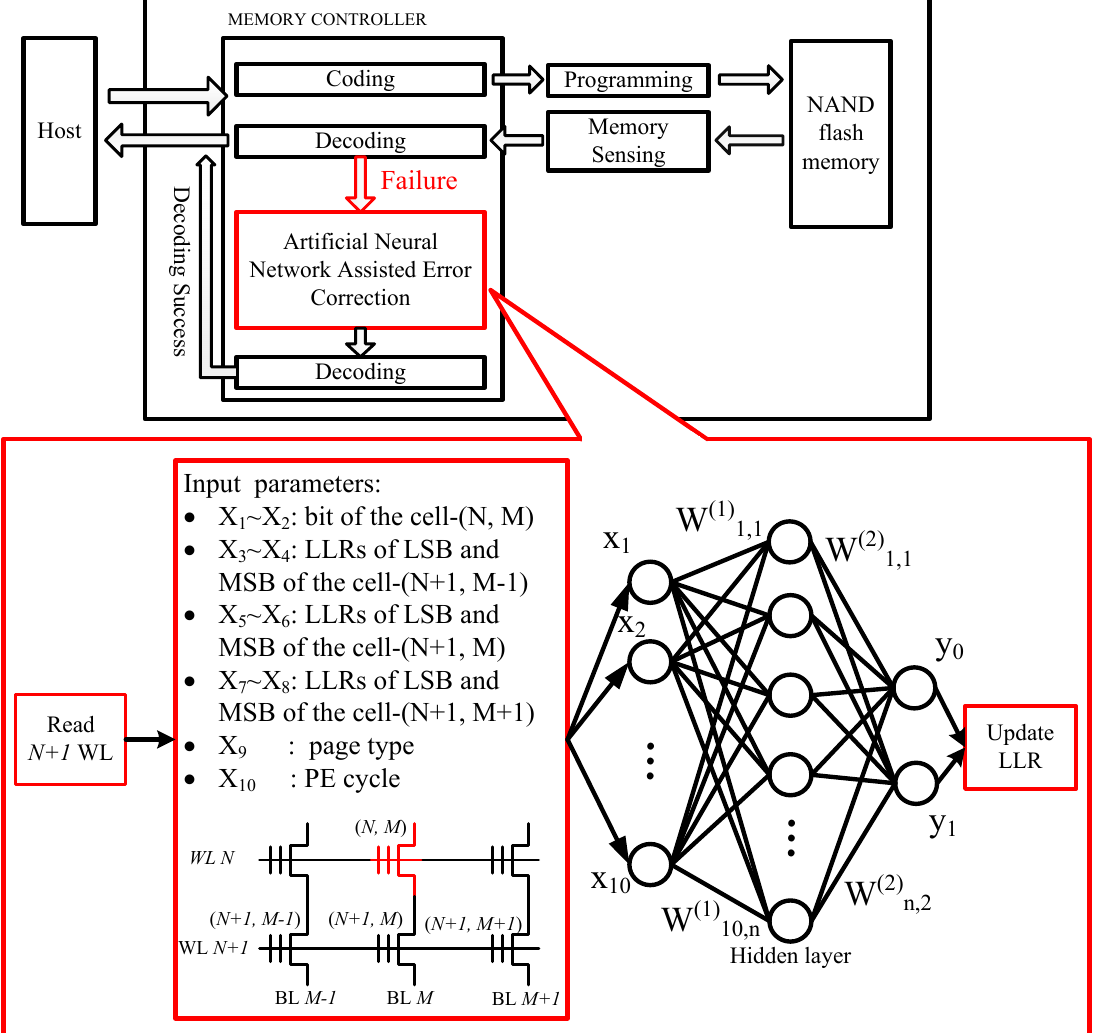
Figure 7. Block diagram of the proposed ANNAEC scheme in NAND flash